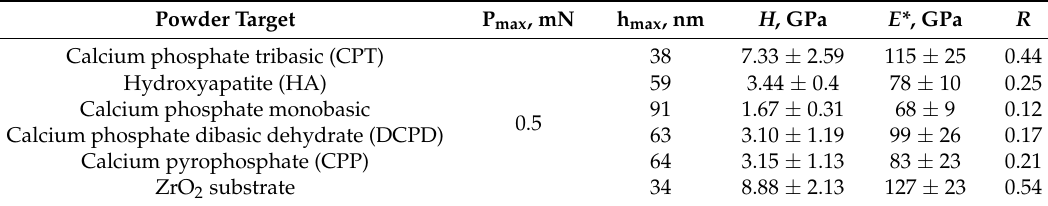
Table 2. Mechanical properties of the Ca-P coatings 1 .